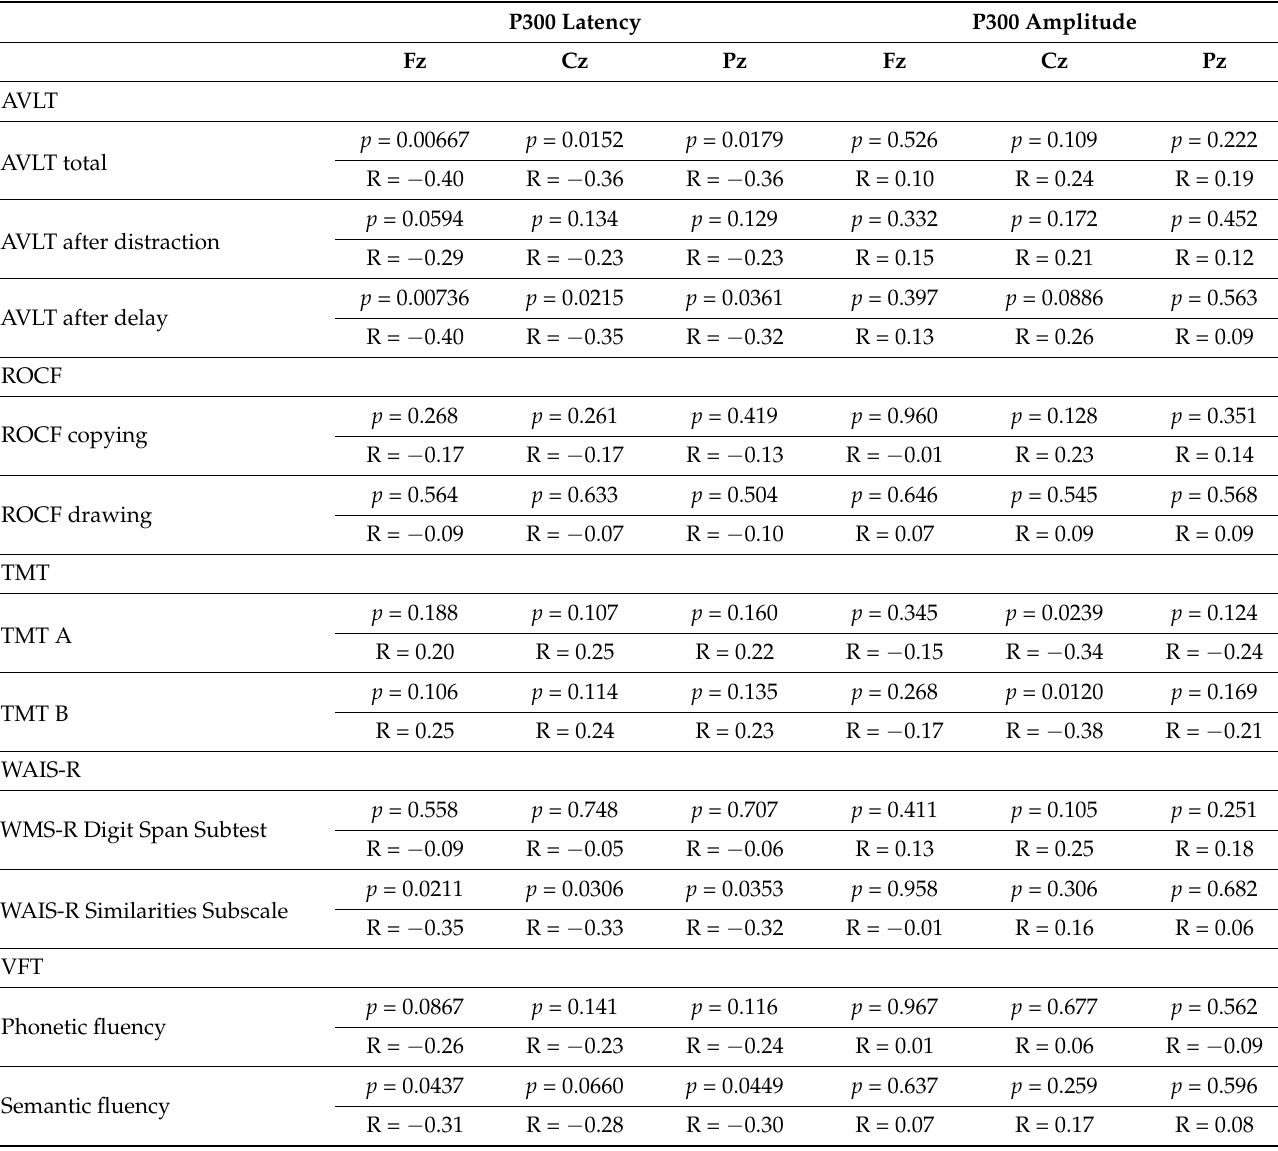
Table 9. Correlations between P300 parameters and neuropsychological test results in the study group (R—Spearman’s rank correlation